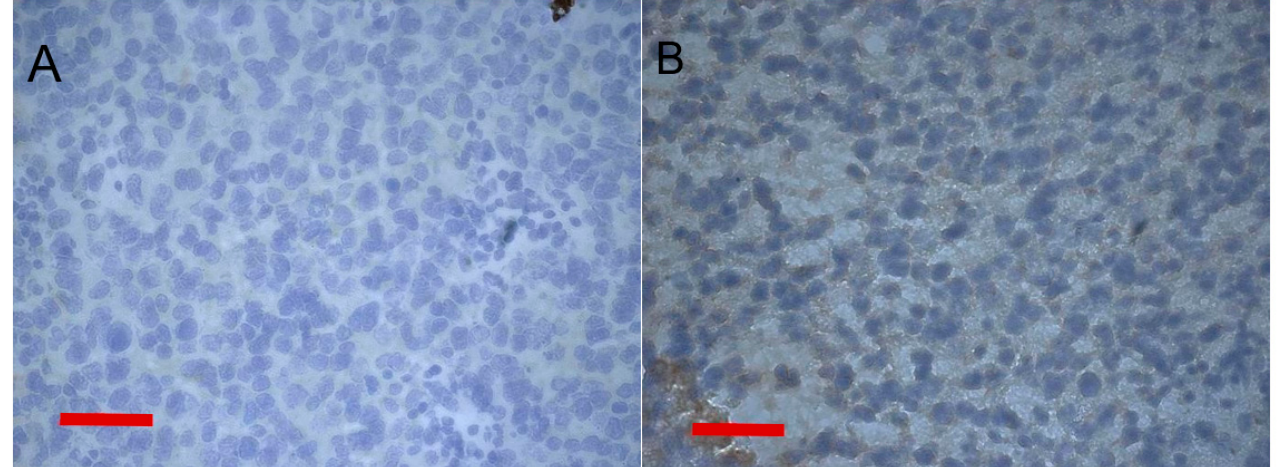
Figure 7. Micrographs of mouse melanoma sections with immunohistochemical verification of epidermal growth factor receptor (EGFR) expression. DNA was stained with hematoxylin. ( A )—M3 tumor section. ( B )—M3-EGFR tumor section. Scale bars represent 100 µm. Semi-quantification of the immunohistochemical data verified that EGFR staining of M3-EGFR tumors is significantly more intense than EGFR staining of parental M3 tumors ( p < 0.03) (Figure S3).